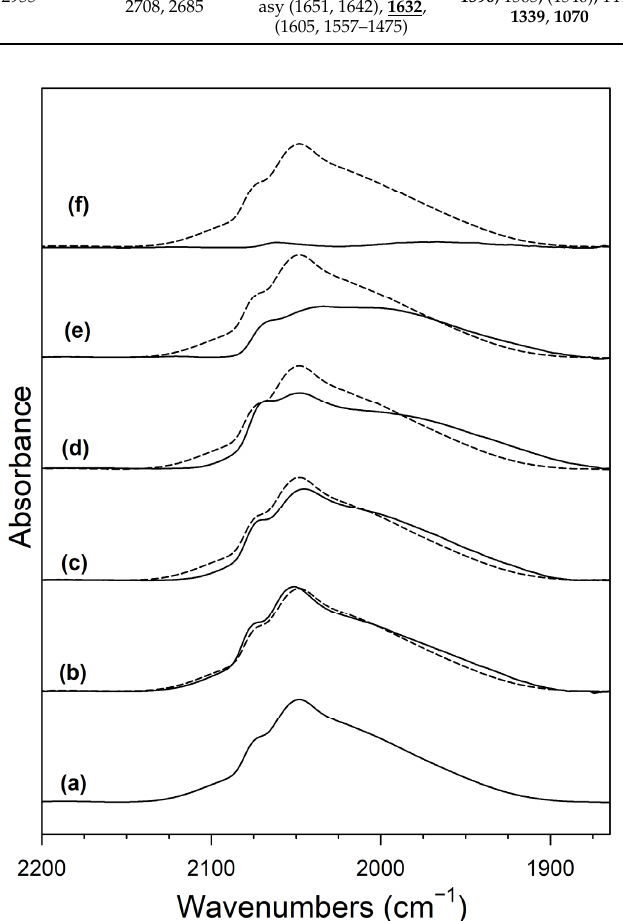
Figure 9. ν (CO) stretching region of Pt carbonyls in DRIFTS of steam reforming of adsorbed formal- dehyde at 150 °C for ( a ) 2%Pt/m-ZrO 2 , and the same with ( b ) 0.5%Na, ( c ) 1%Na, ( d ) 1.8%Na, ( e ) 2.5%Na, and ( f ) 5%Na. Using the unpromoted catalyst as a reference, the ratio of promoted/un- promoted areas follows the trend: ( a ) 100% (reference), ( b ) 104%, ( c ) 97%, ( d ) 93%, ( e ) 64%, ( f ) 1%. Table 2. Formate ν (CH) band region at the maximum intensity (125–175 °C) and other relevant vi- brational positions during temperature stepped formaldehyde/H 2 O reaction using the assignments of Binet et al. [33]. Carbonate band positions were recorded at 300 °C.